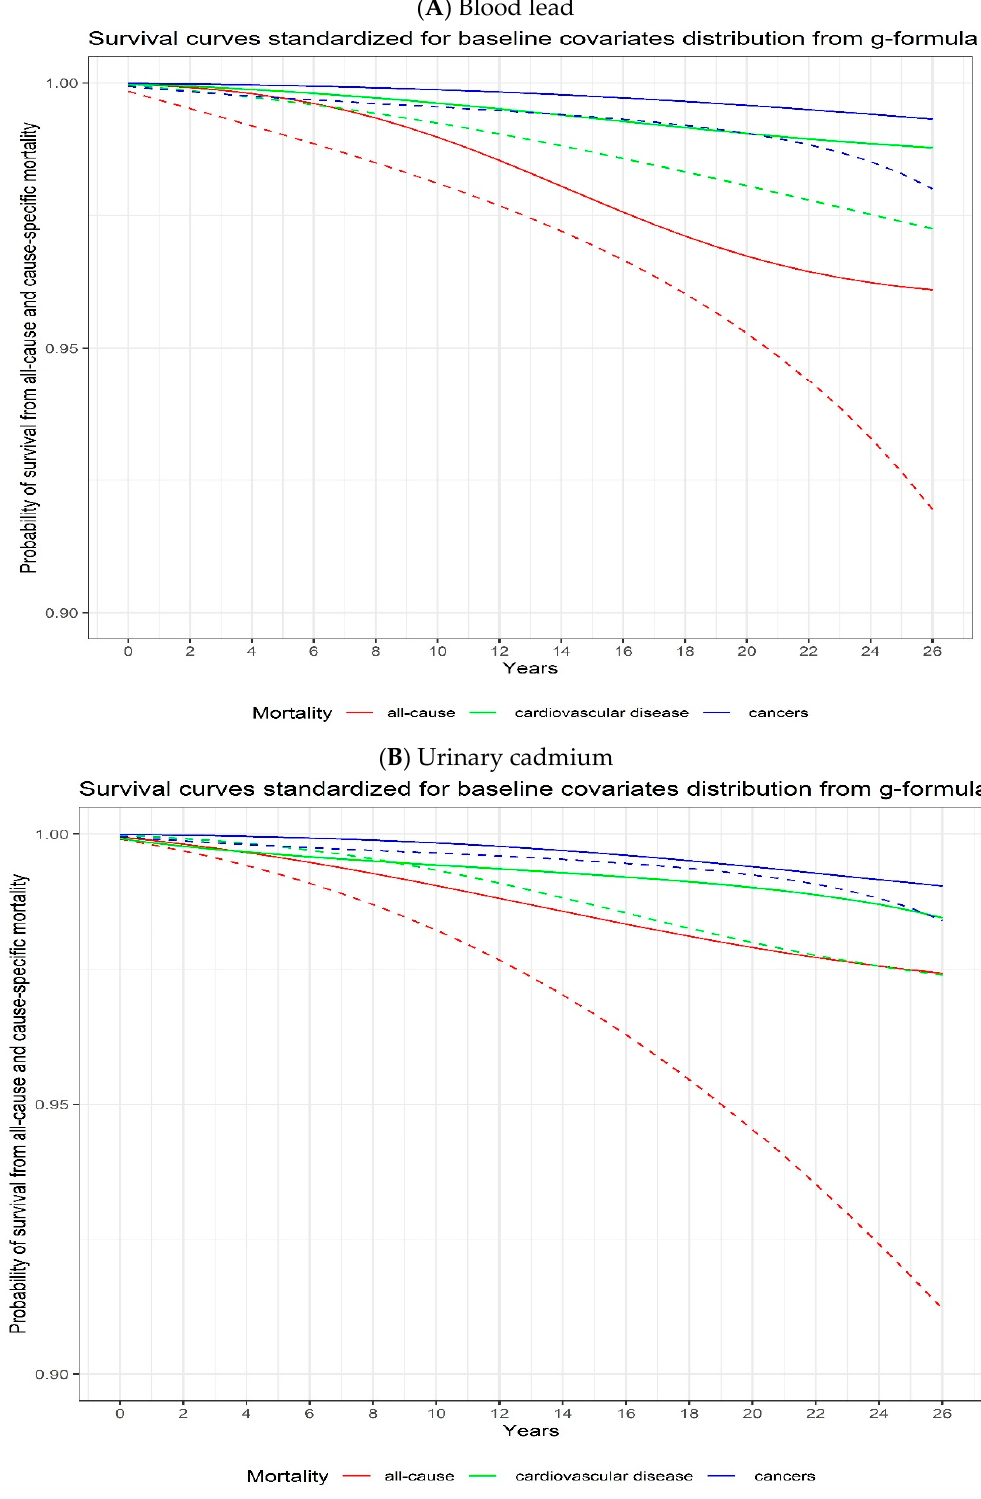
Figure 1. Adjusted all-cause, cardiovascular disease, and cancer mortality risks according to blood lead ( A ) and urinary cadmium ( B ) levels using parametric g-formula with pooled logistic regression models. The solid lines represent the 5th percentile (0.70 μ g/dL for lead and 0.04 μ g/L for cadmium) and the dashed lines represent the 95th percentile (9.70 μ g/dL for lead and 1.63 μ g/L for cadmium). Robust 95% confidence intervals (CIs) for each exposure category estimated by bootstrapping (in the pooled logistic regression model ) are presented in Table 2.